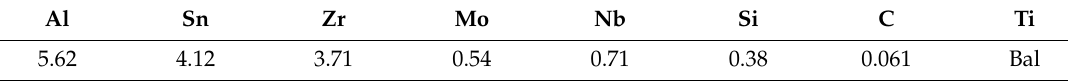
Table 1. Chemical compositions of high-temperature titanium alloy (mass fraction / %).